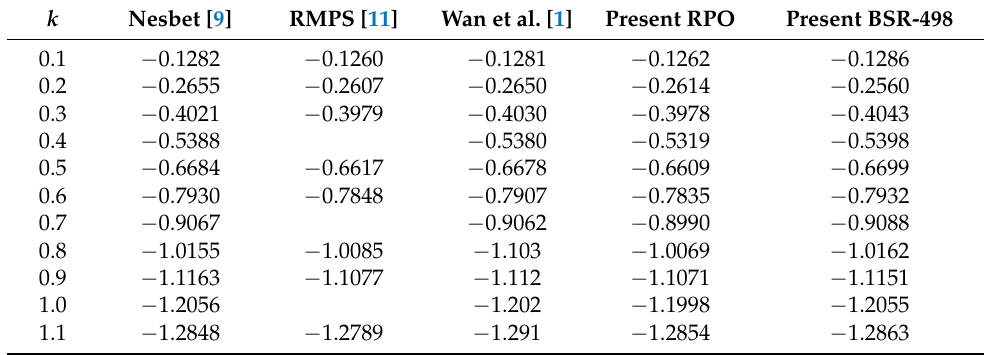
Table 1. S -wave phaseshift as a function of linear momentum k for infinite nuclear mass.